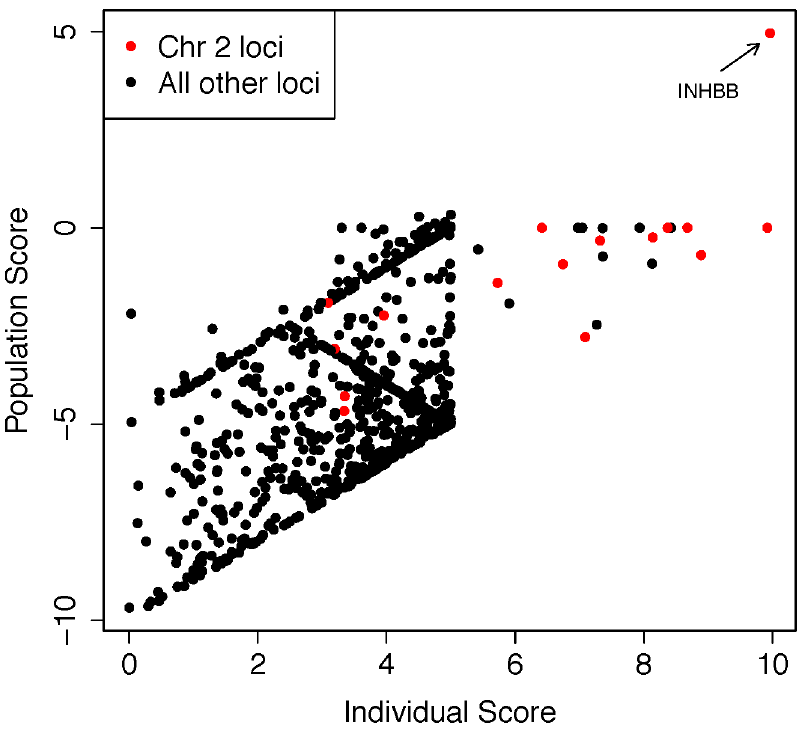
Figure 5. Analysis of exome sequencing data identifies a candidate azoospermia mutation in the case of UPD2. We performed whole- exome sequencing on the case of UPD2 in an attempt to identify a potential genetic cause for this man’s azoospermia. We constructed a scoring method to rank order the exome variants in two dimensions: (i) within the set of variants seen in this single exome, the ‘‘Individual Score’’ and (ii) across a large set of exome sequences, the ‘‘Population Score’’. For each exome variant, the Individual Score, P ind, , was constructed by summing normalized predictions of functional impact from 5 commonly used annotation algorithms: PhyloP, PolyPhen2, SIFT, GERP, and LRT. This score was then multiplied by the ploidy of the mutant allele (e.g. 1 6 for a heterozygous genotype and 2 6 for a homozygous genotype) creating a final Individual Score ranging from 0–10. We also calculated the Individual Score for all variation in the 1000 genomes Phase I sequencing data. To construct the ‘‘Population Score’’ for each variant in the UPD individual, P pop , we identified the maximum Individual Score variant in the corresponding gene, P max , within the 1000 genomes data, and defined P pop =P ind 2 P max . The purpose of the Population Score is to scale the importance of each Individual Score by the extent of pathogenic variation that exists in the population at each gene. Only sites with minor allele frequencies less than 10% in both the 1000 genomes data and the Exome Variant Server (http://evs.gs.washington.edu/EVS/) were considered in the analysis. When examining the joint distribution of P pop and P ind for the UPD2 individual, we saw an enrichment of large scores for variants on chromosome 2, as expected. The most extreme variant on both scales was a homozygous nonsense mutation in the gene INHBB , the implications of which we discuss in Figure